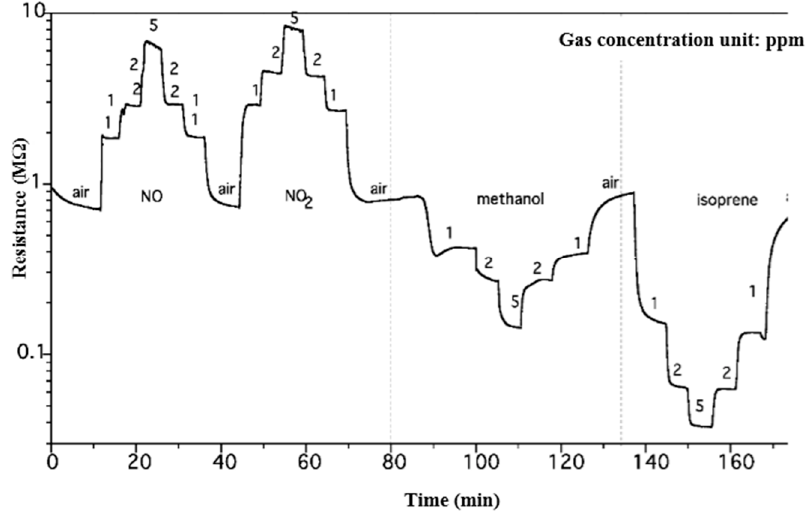
Figure 2. Resistance change of h -WO 3 with exposure to NO, NO 2 , methanol, and isoprene at 350 °C.